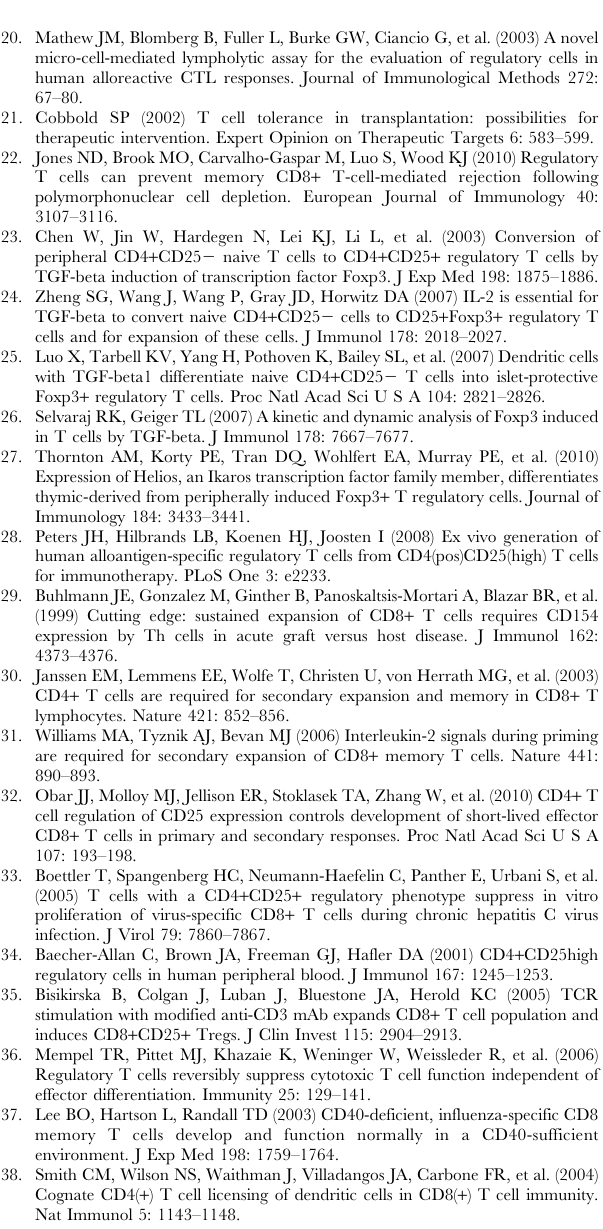
Table S1 Assessment of cell-cell contact requirement for